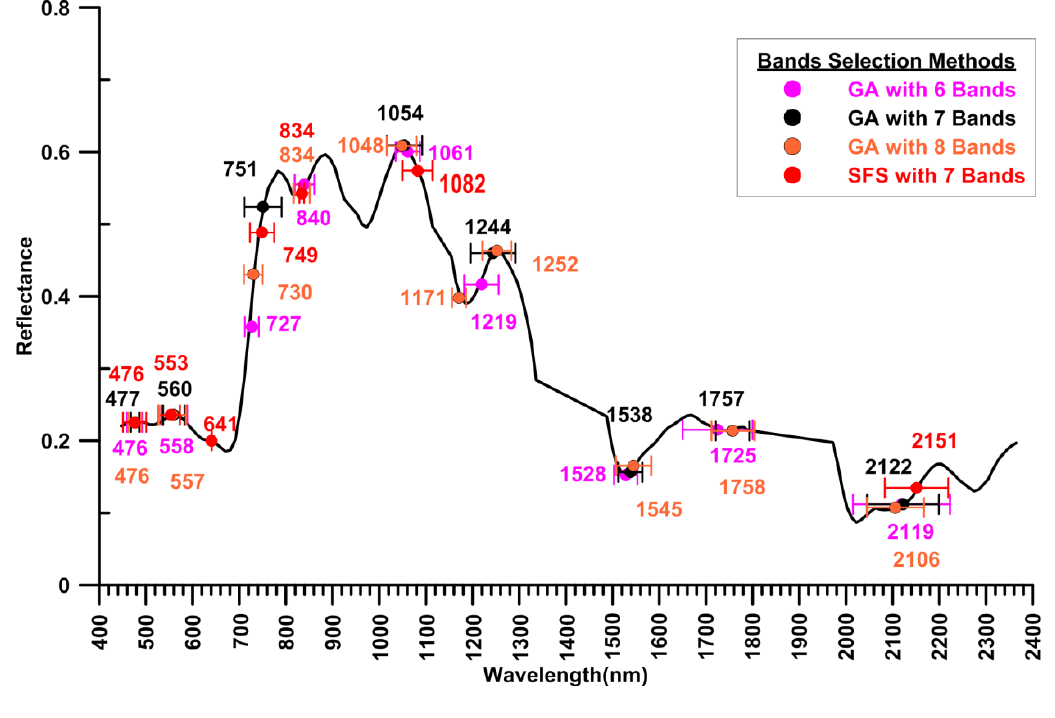
Figure 5. The principal spectral locations and the standard deviation bars of the 6-channel (blue), 7-channel (black), and 8-channel (green) chromosomes selected by the genetic algorithm against the locations selected by the traditional SFS method